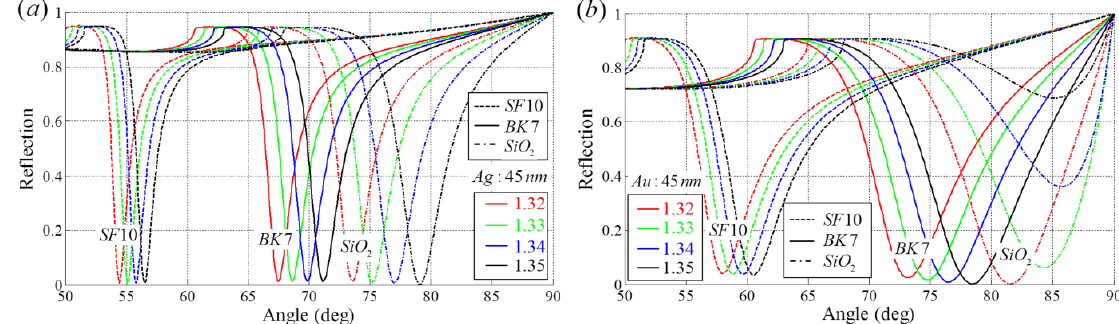
Figure 3. Reflection spectra of sensing response with different prism materials (a) with a 45 nm Ag metal film and (b) a 45 nm Au metal film (when a 633 nm light source for